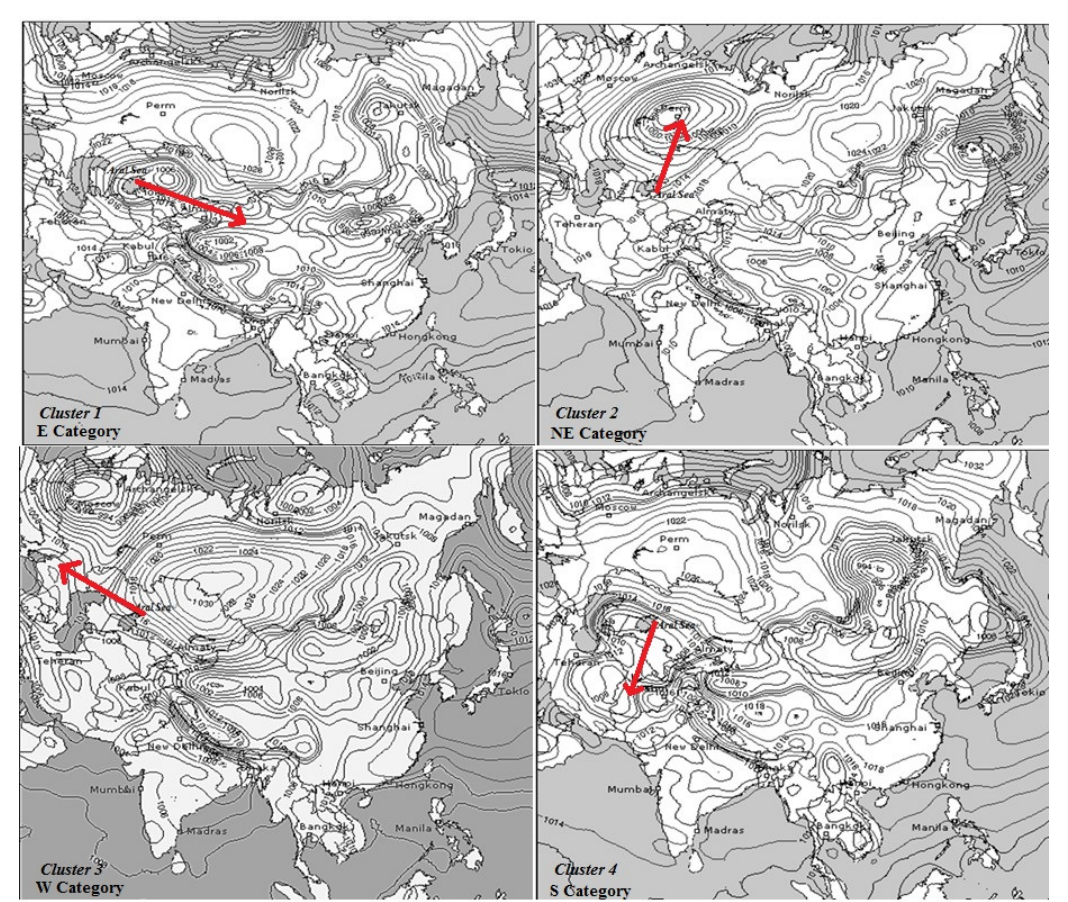
Figure 5. Examples of synoptic pressure pattern for each cluster. Note: the red arrow in the figure indicates the movement direction of air parcel within different air pressure system